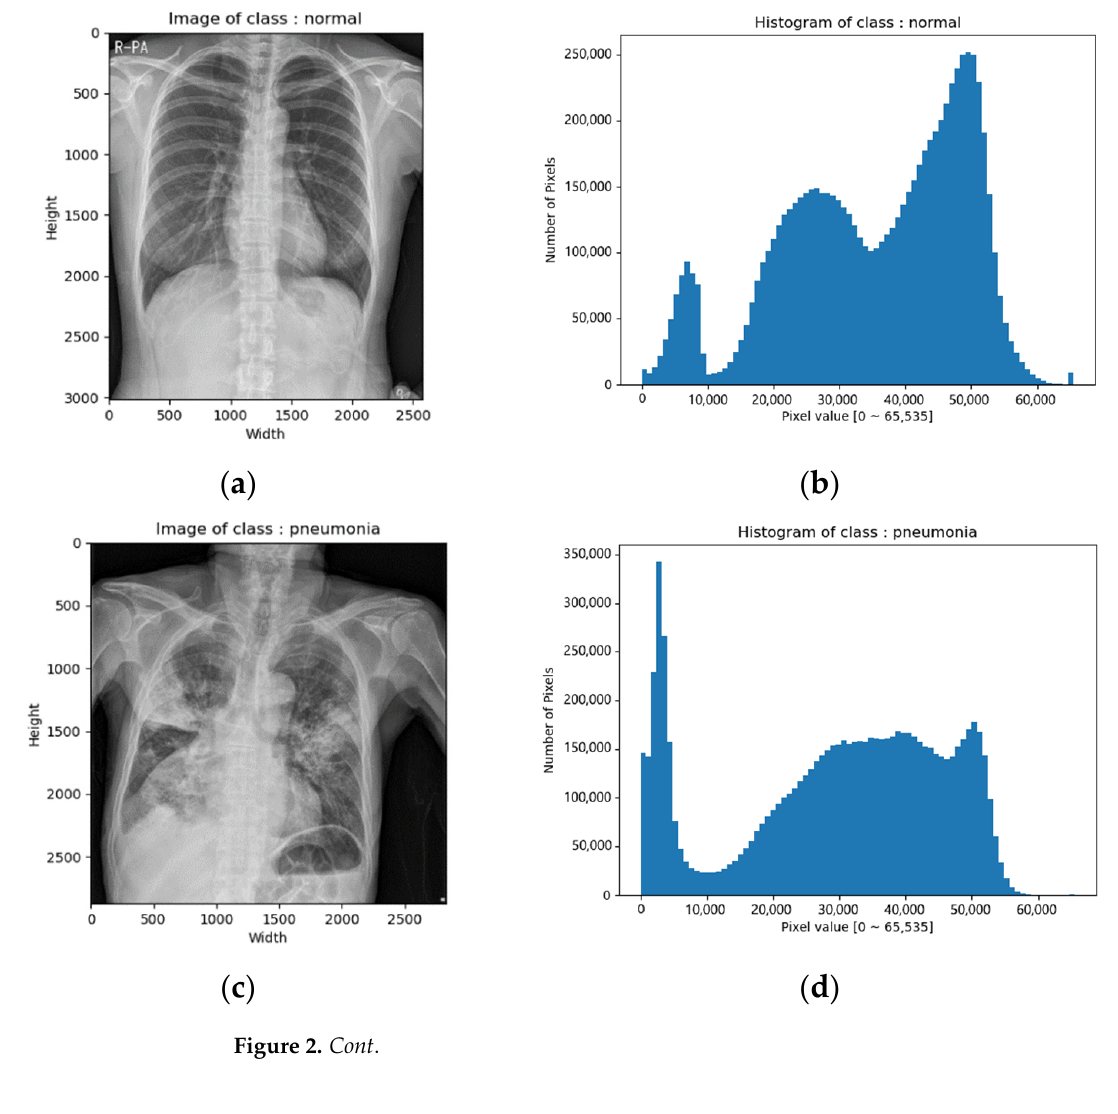
( h ) Figure 2. CXR images of SCH data set: ( a ) image of normal class; ( b ) histogram of normal class; ( c ) image of pneumonia class; ( d ) histogram of pneumonia class; ( e ) image of pneumothorax class; ( f ) histogram of pneumothorax class; ( g ) image of tuberculosis class; ( h ) histogram of tuberculosis class.